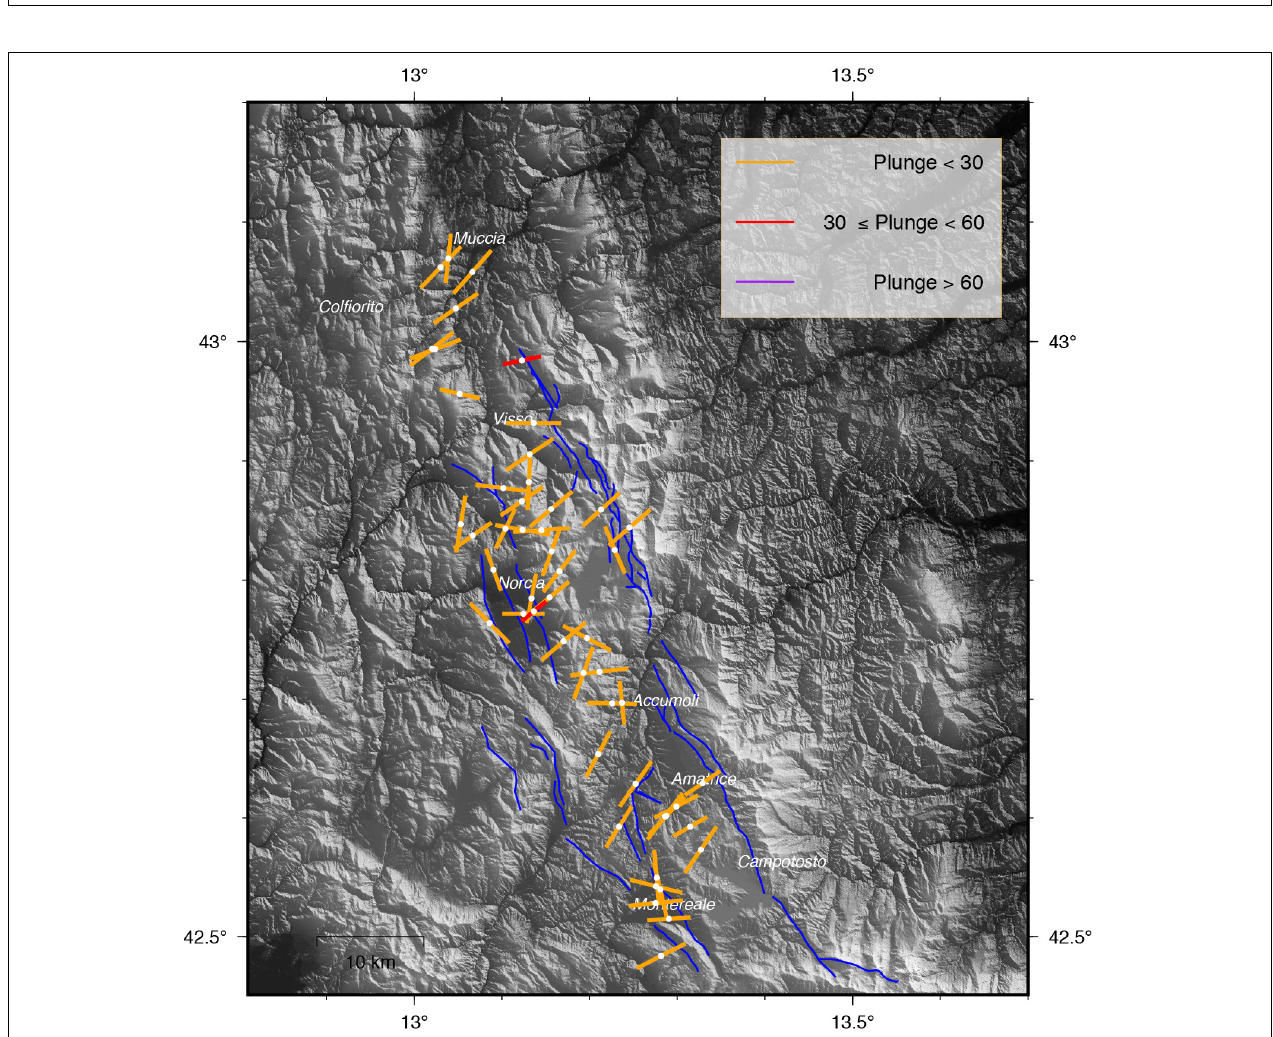
FIGURE 12 | T -axes of focal mechanism solutions determined in the present study for the AVN area. The length of each bar is inversely proportional to the plunge of the axis; colors are related to the 3 groups of plunges reported in the inset; blue lines are the normal faults mapped in this area while red lines are surface ruptures of the AVN seismic sequence (Pucci et al., 2017; Civico et al., 2018; Villani et al., 2018).